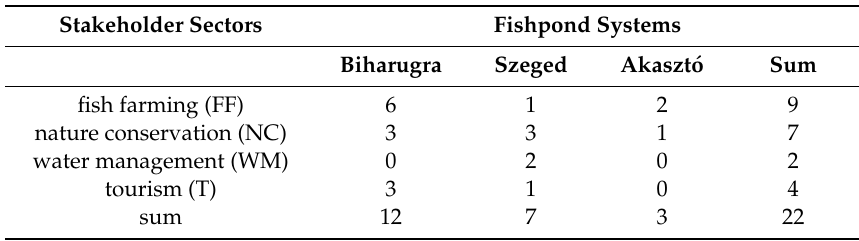
Table 1. The number of interviewed key-informants, organized by their related fishpond systems and stakeholder